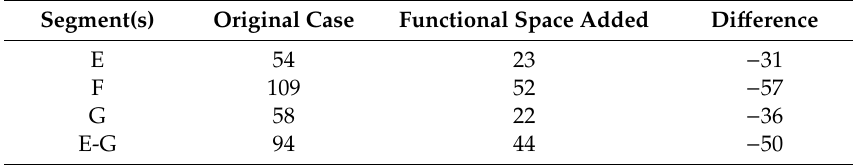
Table 6. Condensation days on average at each simulation point on segments E to G.